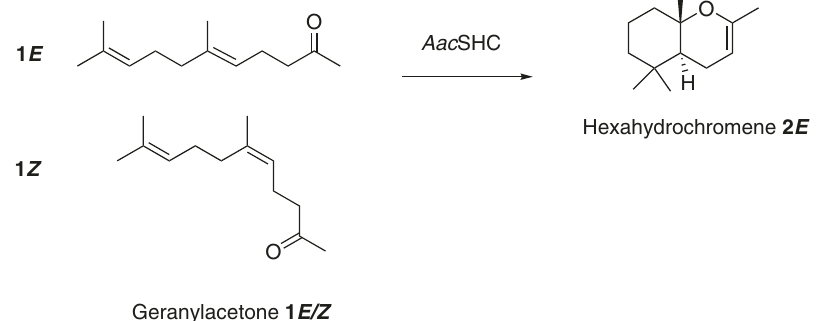
Fig. 2 | Biotransformation of geranyl acetone 1 E/Z with the wildtype AacSHC. Only the isomer 1 E is converted into product 2 E by the enzyme Aac